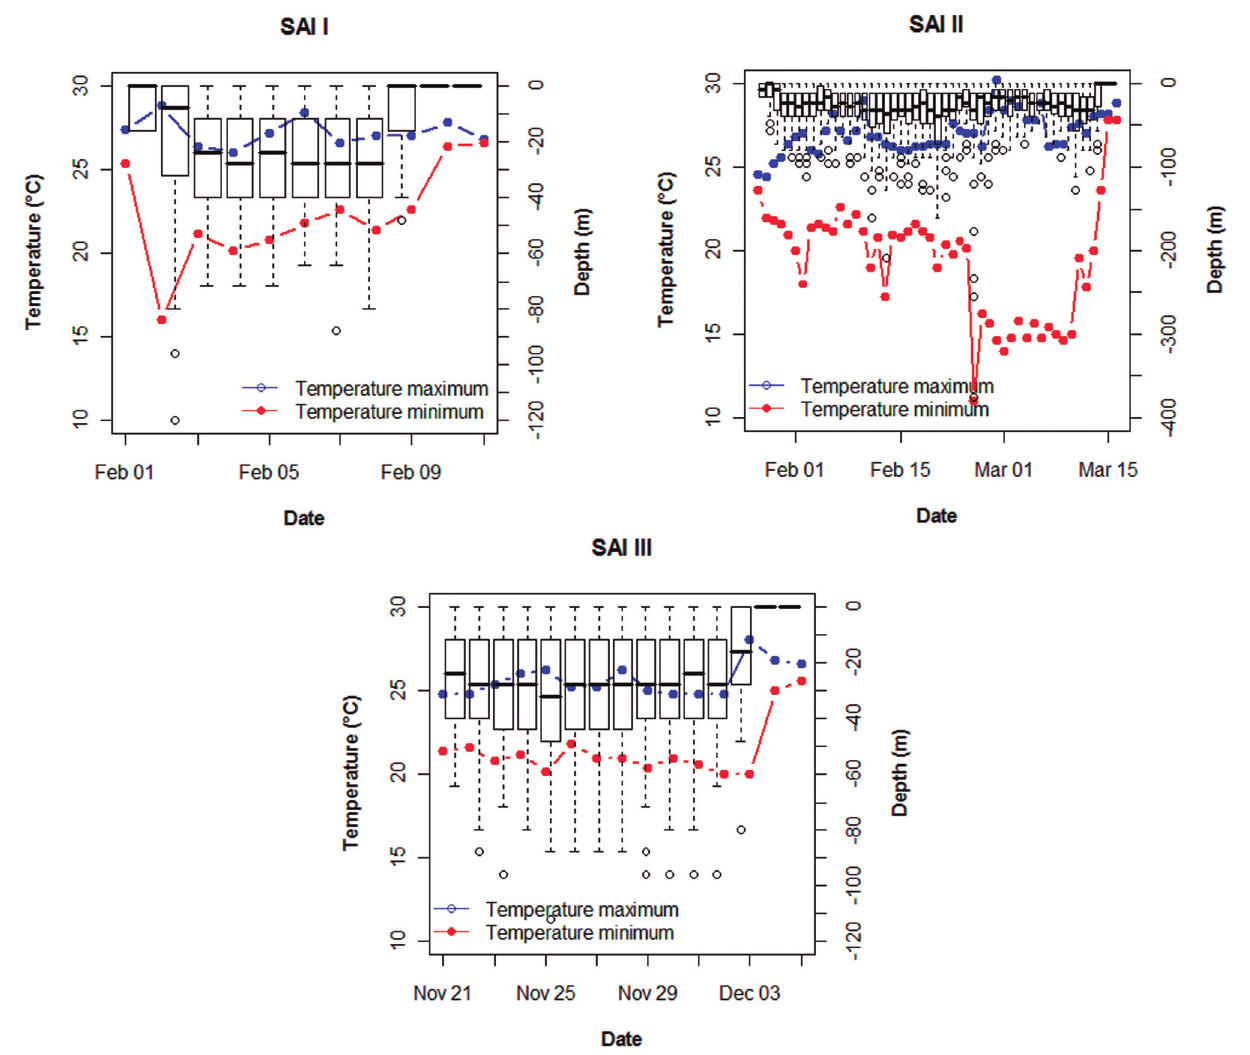
Fig. 3. Minimum and maximum daily temperature and depth experienced by sailfish I, II and III. Box-plots represent the depths experienced by tagged